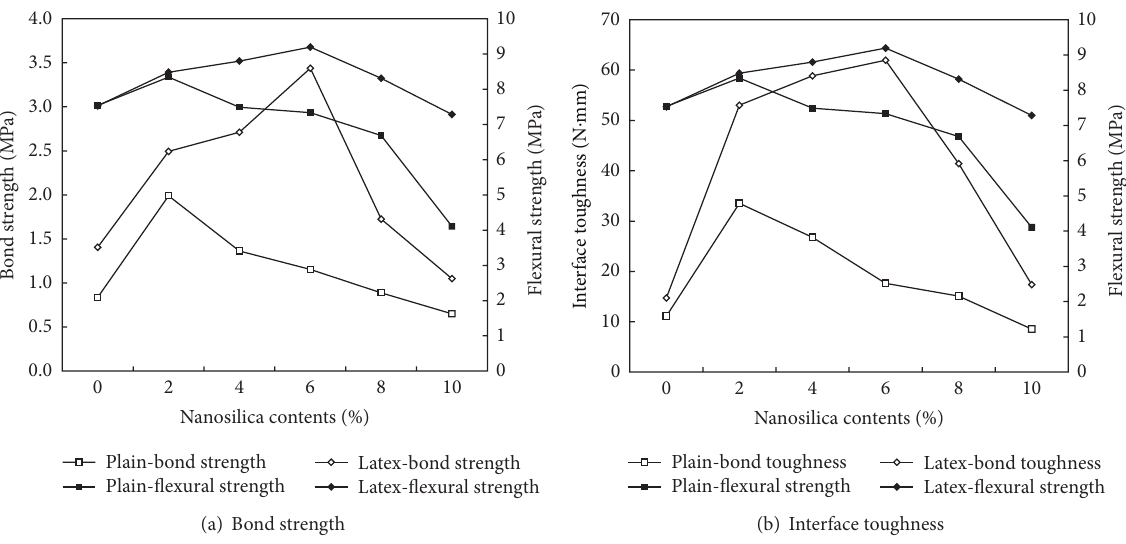
Figure 6: Relationship between flexural strength and bond performance.